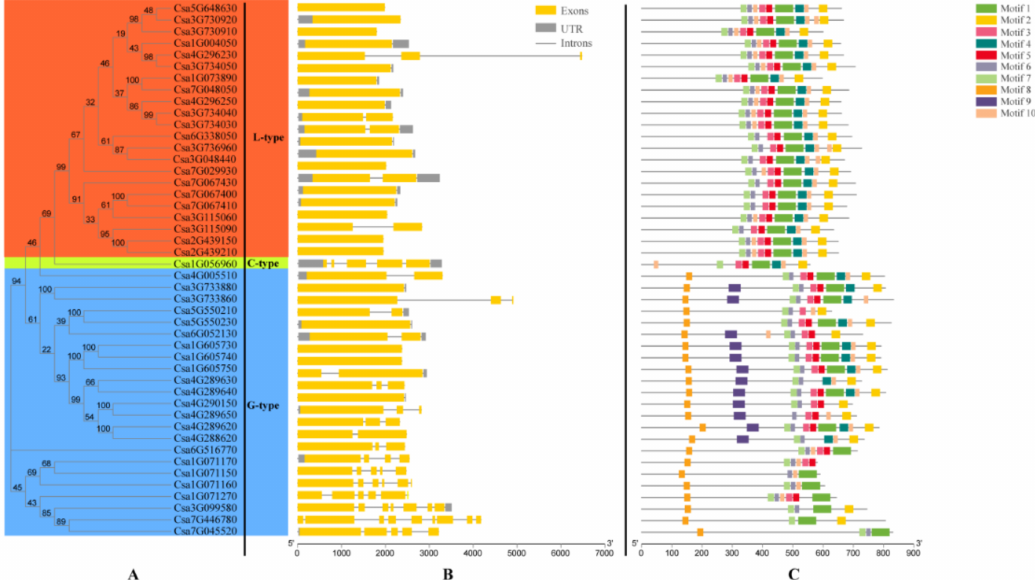
Figure 3. An analytical view of the CsLecRLK genes. ( A ) Protein maximum likelihood tree. The tree was constructed using a maximum-likelihood method, and bootstrap values were calculated with 1000 replications using MEGAX; ( B ) Gene structure: The lines represents the introns. The gray squares represents the 3’ UTR and the 5’ UTR. The yellow square represents the exon; ( C ) Protein structure. The search for 10 common motifs shared among the CsLecRLK proteins. Di ff erent colors represents di ff erent